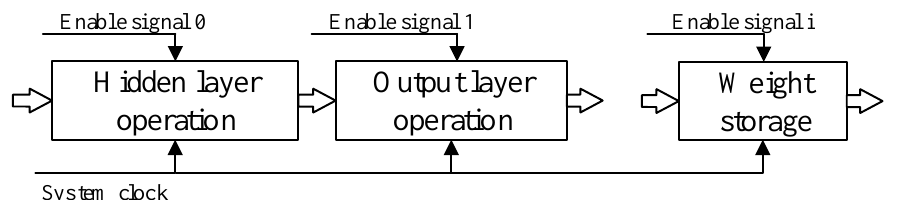
Figure 6. Network execution sequence